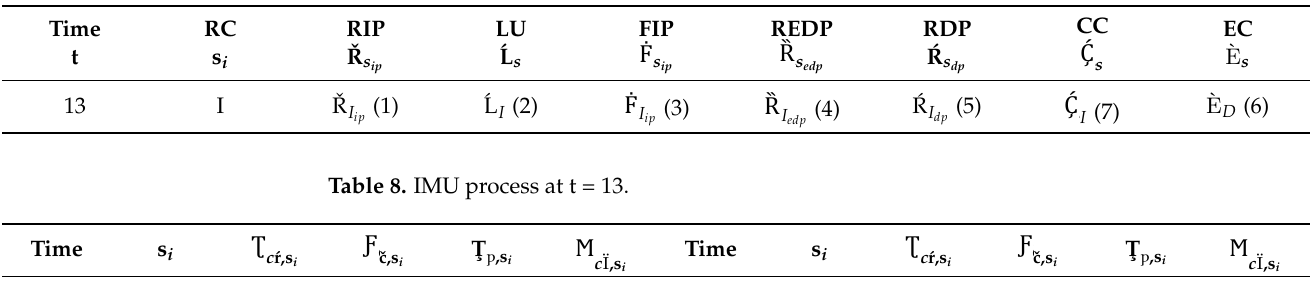
Table 7. Caching process at t = 13.